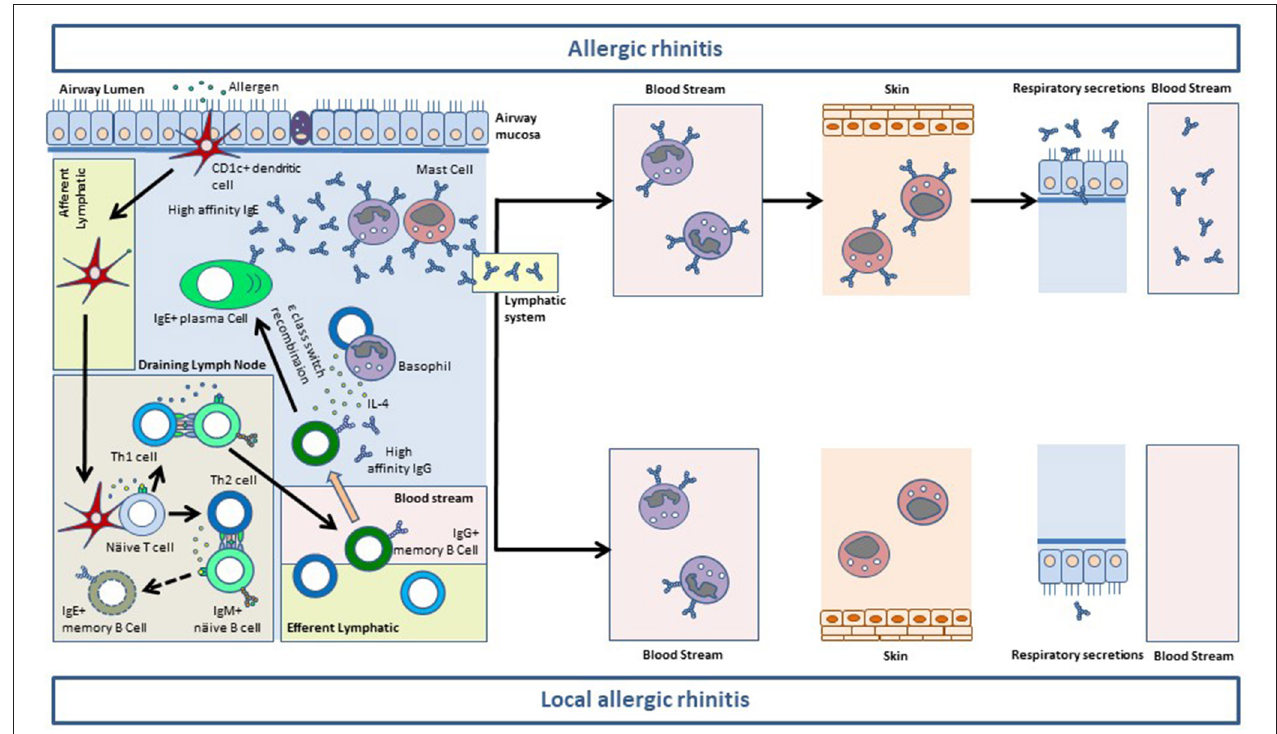
FIGURE 1 | Mucosal synthesis of allergen-specific (s)IgE in the airway mucosa of allergic rhinitis (AR) and local allergic rhinitis (LAR) patients. After taking up the allergen, CD1c + myeloid dendritic cells traffic to the germinal center of the draining lymph nodes. Here, dendritic cells activate allergen-specific naïve CD4 + T cells to generate Th1 and Th2 cells. Th1 cells stimulate allergen-specific IgM + naïve B cells which undergo class switch recombination (CSR) to IgG and somatic hypermutation to give rise to IgG + memory B cells (among other B and plasma cell subsets). The antibodies produced by IgG + memory B cells display a high affinity for the allergen. Allergen-specific Th1 and IgG + B cells exit the lymphoid system through the efferent vessels and reach the blood stream. Activated Th2 cells in the germinal centers also stimulate IgM + näive B cells which undergo CSR to IgE. Nevertheless, IgE + B cells cannot efficiently carry out their somatic hypermutation, and die by apoptosis before exiting the germinal centers. Conversely, allergen-specific Th2 cells reach the blood stream and extravasate to the airway mucosa, together with Th1 cells (not shown) and IgG + memory B cells. In the lamina propia IgG + memory B cells can undergo sequential CSR to IgE upon allergen re-encounter (not shown) and stimulation with IL-4 provided by Th2 cells and basophils. This process results in the generation of IgE + plasma cells releasing vast amounts of high-affinity sIgE to the lamina propia of the airway mucosa. Mucosal sIgE binds to Fc ε RI on resident basophils and mast cells and sensitize them for activation. After saturating the Fc ε RI receptor system of the mucosa, sIgE reaches the blood stream to bind to Fc ε RI on circulating basophils. In patients with AR, sIgE saturates the receptor system of blood basophils and subsequently binds to Fc ε RI expressed on the mast cells residing at peripheral tissues including the skin. After saturating the Fc ε RI receptor system of the organism, sIgE can be found free in serum and in the respiratory secretions of AR subjects. In patients with LAR, the sIgE synthetized at the mucosal level is sufficient to saturate Fc ε RI on mucosal resident mast cells and basophils, and in > 50% of cases is also sufficient to sensitize peripheral basophils. Nevertheless, LAR patients do not have enough sIgE to saturate Fc ε RI on peripheral basophils, and thus sIgE is not found on skin mast cells or serum. Most patients with LAR do not have sIgE in respiratory secretions either, although low levels are sometimes detected. This phenomenon probably corresponds to a small sIgE leakage through the epithelim, before the antibody exits the mucosa via the lymphatic